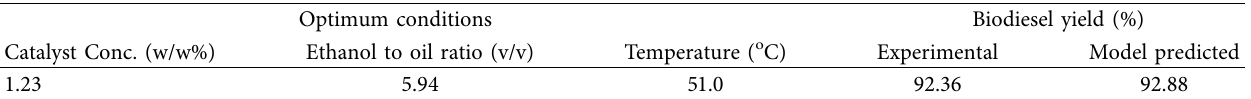
Table 7: Model validation by experimental results under optimum